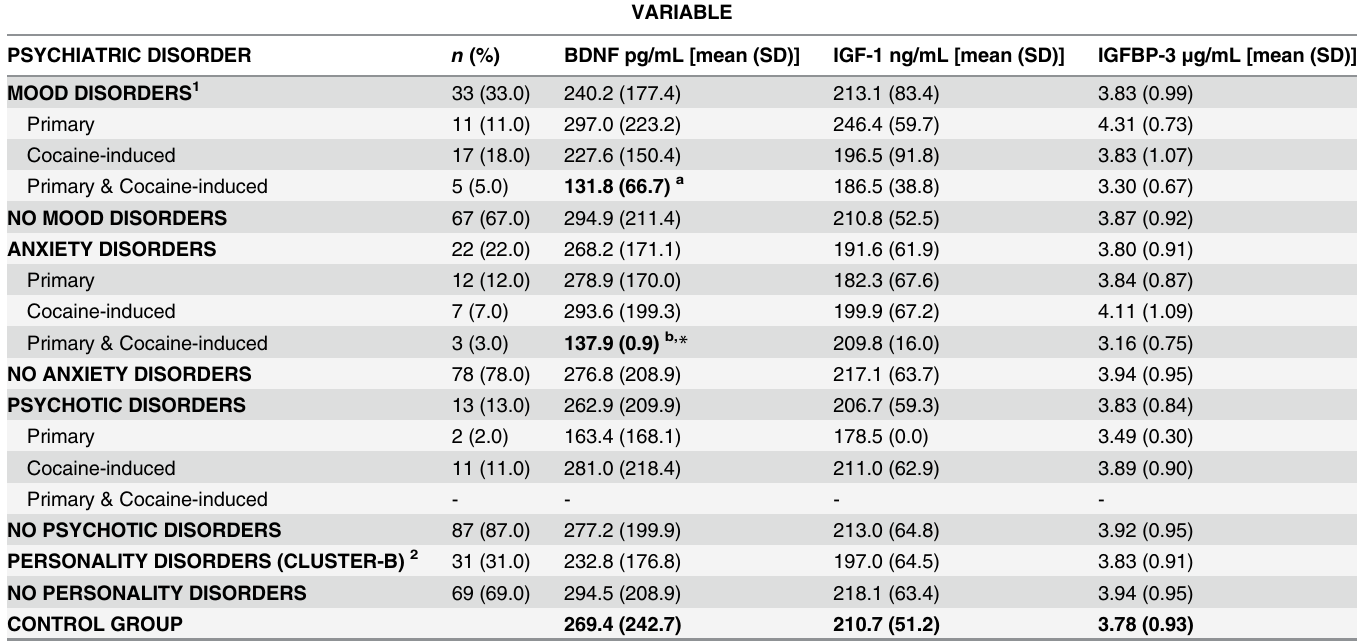
Table 5. Plasma concentrations of BDNF, IGF-1 and IGFBP-3 in abstinent cocaine users grouped by diagnosis of common psychiatric disorders in substance